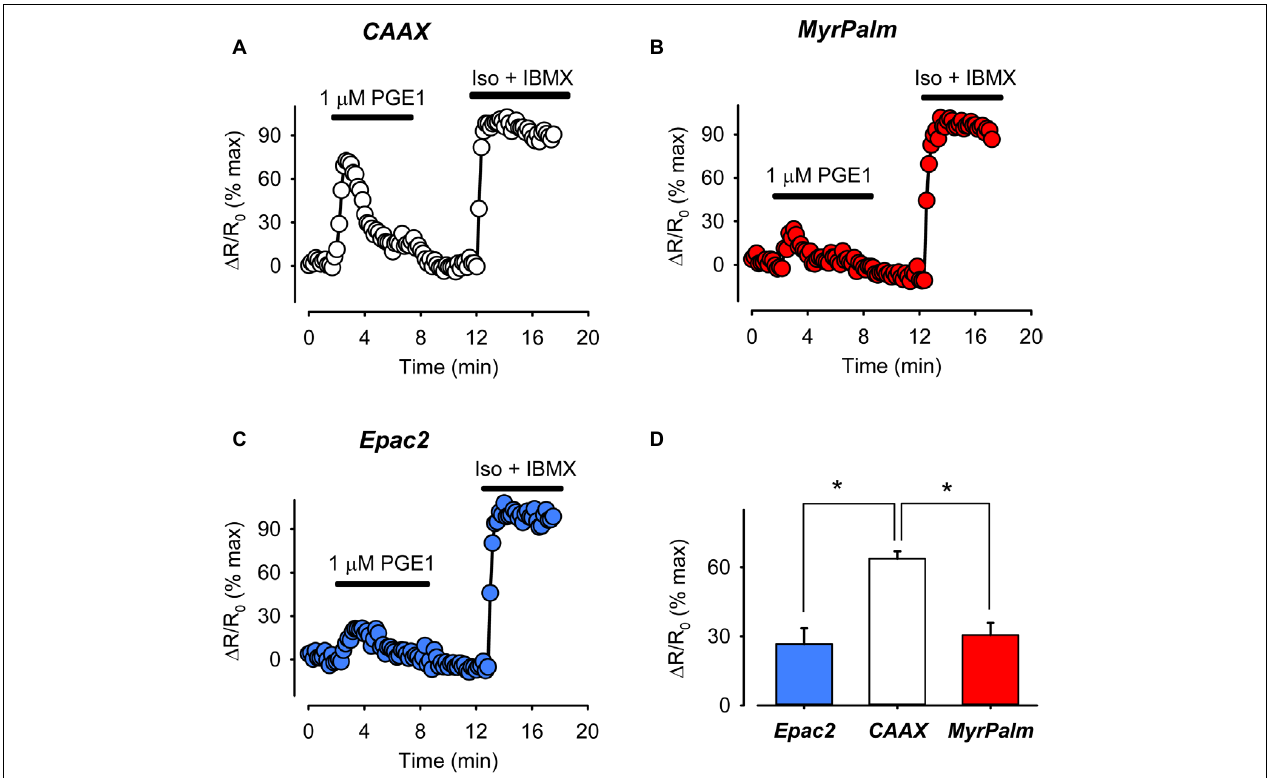
FIGURE 4 | The prostaglandin receptor (EPR) agonist PGE1 produces greater cAMP response in non-raft-associated membrane domains. (A–C) Representative time course of changes in the normalized FRET response ( (cid:49) R/R 0 ) in cells expressing Epac2-CAAX (CAAX, white circles), Epac2-MyrPalm (MyrPalm, red circles), and Epac2-camps (Epac2, blue circles), under control conditions and following exposure to 1 µ M PGE1. Maximal response was elicited by subsequent exposure to 1 µ M Iso plus 100 µ M IBMX (Iso + IBMX). (D) Summary of average FRET responses to 1 µ M PGE1 in cells expressing Epac2-camps (n/N = 5/3, blue bar), Epac2-CAAX (n/N = 5/3, white bar), and Epac2-MyrPalm (n/N = 6/3, red bar). Epac2-CAAX response to 1 µ M PGE1 was significantly different from Epac2-camps and Epac2-MyrPalm responses ( ∗ p < 0.05, one-way ANOVA followed by Holm-Sidak method for pairwise multiple